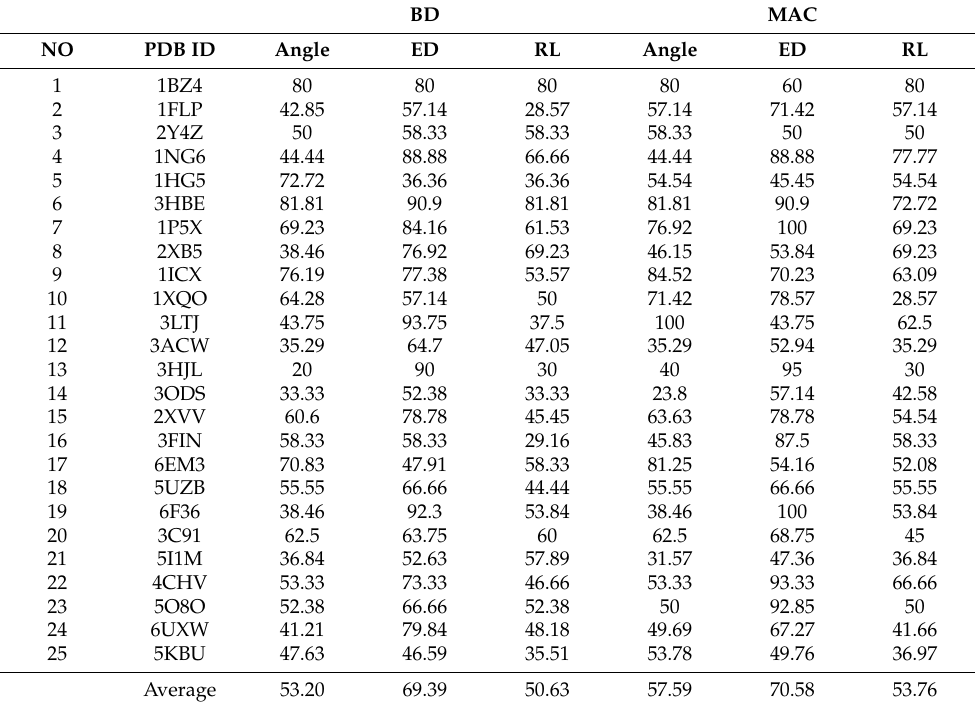
Table 3. The accuracy of the three SSEs correspondence sets using two scoring functions.